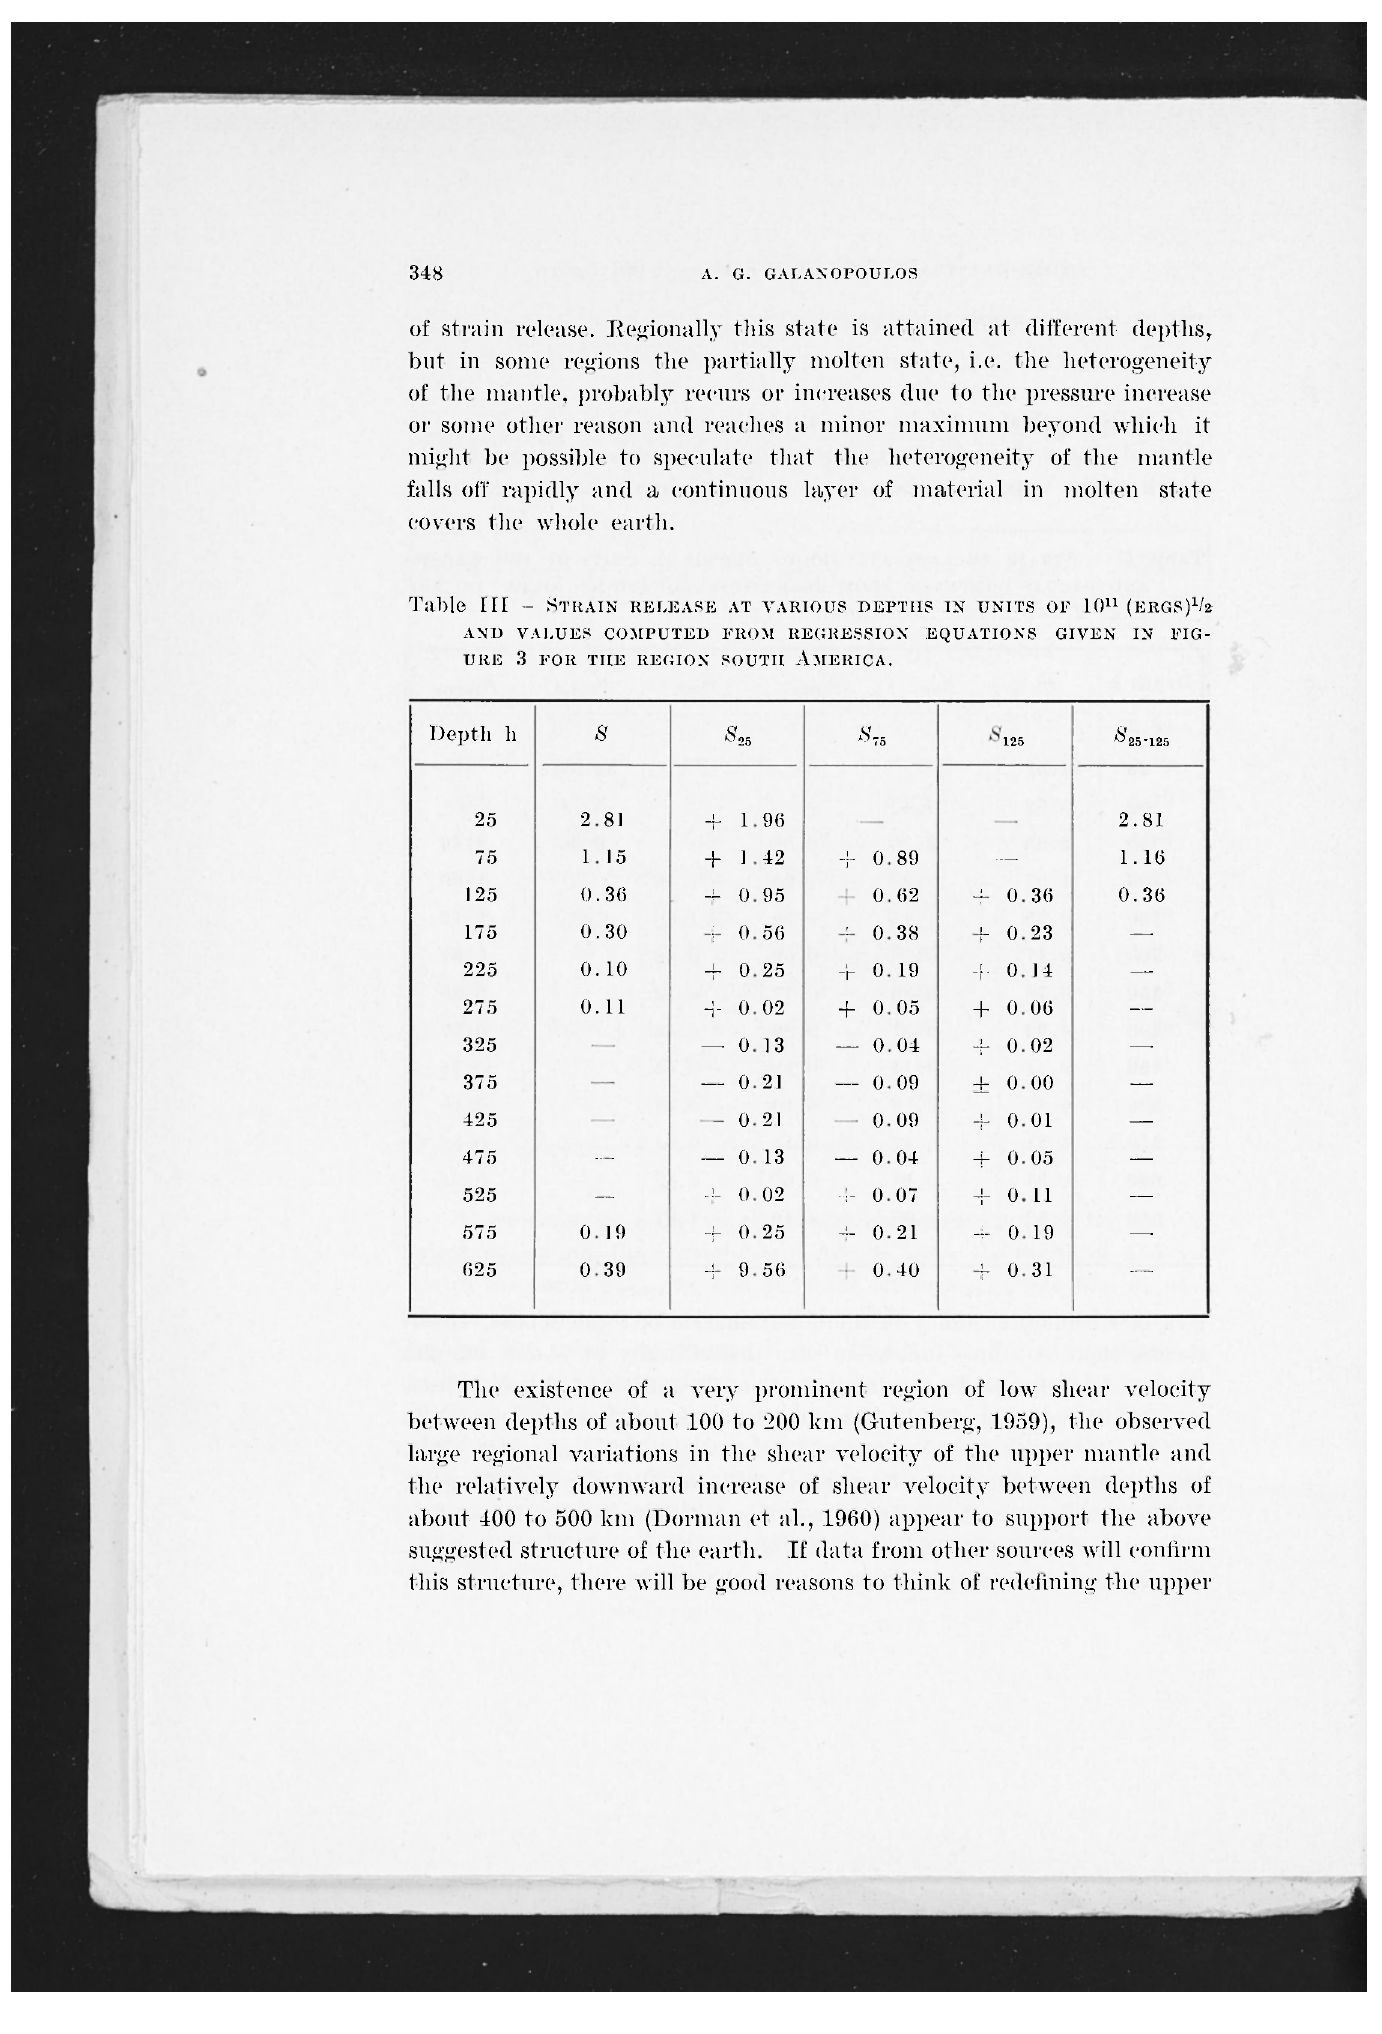
Table I II - STRAIN RELEASE AT VARIOUS DEPTHS IN UNITS or 10 11 (ERGSJVS AND VALUES COMPUTED FROM REGRESSION EQUATIONS GIVEN IN FIG- URE 3 FOR THE REGION SOUTH AMERICA.